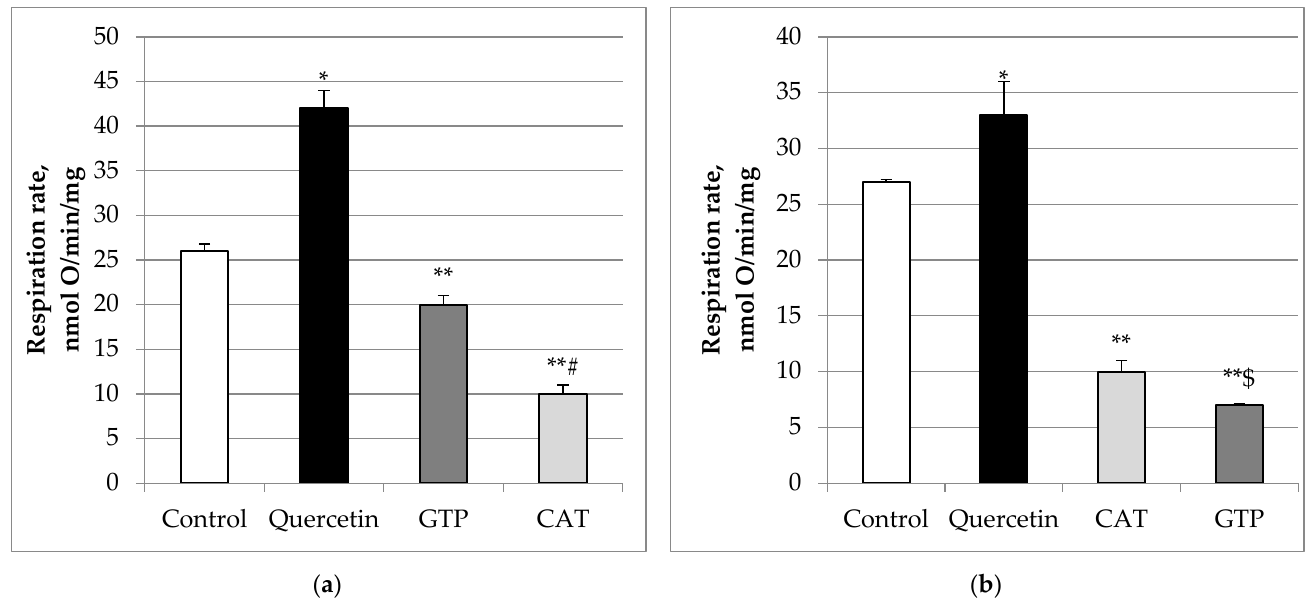
Figure 2. Effect of GTP ( a ) and CAT ( b ) on mitochondrial State 2 respiration rate stimulated by quercetin. The mitochondrial State 2 respiration (V 2 ) rate was recorded in a medium supplemented with mitochondria and substrates (5 mM glutamate + 5 mM malate) in the presence of quercetin (9 µM). Then, guanosine triphosphate (GTP, 30 µM), an inhibitor of UCP, was added followed by the addition of carboxyatractyloside (CAT, 4 µM), an inhibitor of the adenine nucleotide translocator (Figure 2a). Similar experiments were performed in a different order (instead of CAT, GTP was added at first, and then CAT (Figure 2b). Mitochondrial respiration rates are expressed as nmolO/min/mg. * Statistically significant difference ( p < 0.05) compared to control (i.e., to State 2 respiration rate without quercetin). ** Statistically significant difference ( p < 0.05) compared to State 2 respiration rate (V2) in the presence of quercetin. **# Statistically significant difference ( p < 0.05) as compared to GTP-group. **$ Statistically significant difference ( p < 0.05) compared to